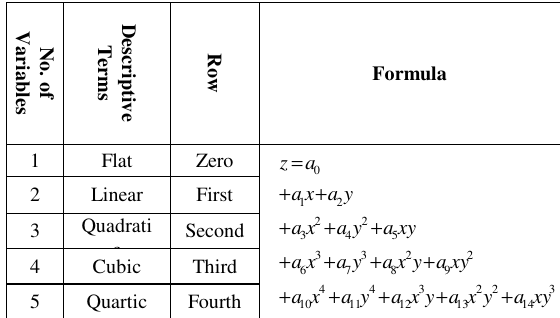
Table 3: Polynomial Function for Surface Reconstruction